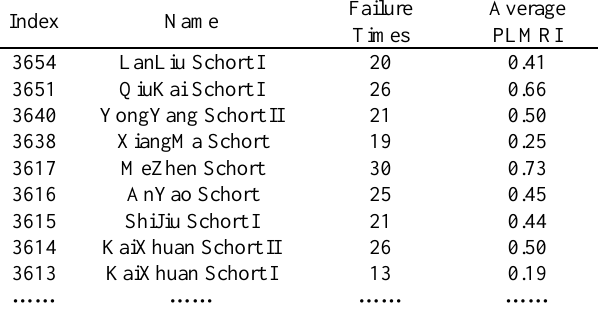
Table 3 Failure times and historical average